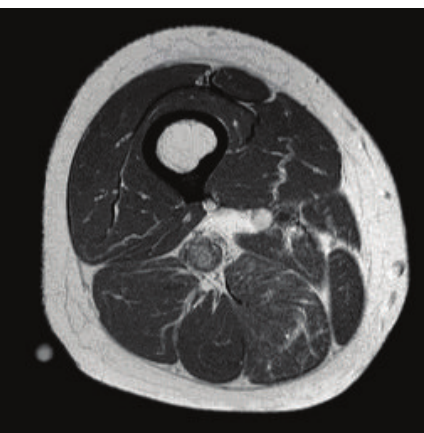
Figure 1: Axial MRI imaging of the right thigh demonstrating the mass originating from the sciatic nerve.